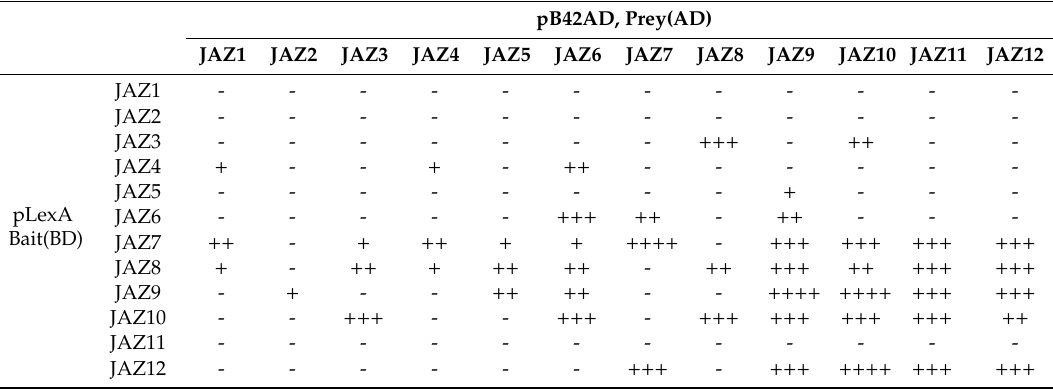
Table 5. Yeast two-hybrid analysis of protein interactions between JAZ.